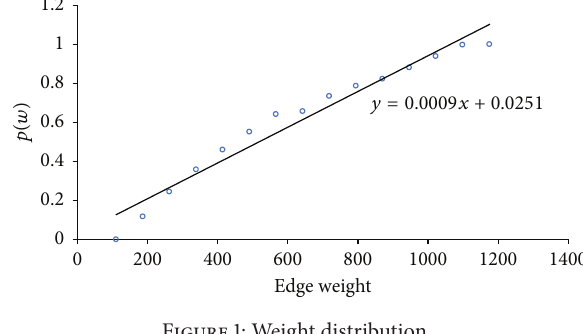
Figure 1: Weight